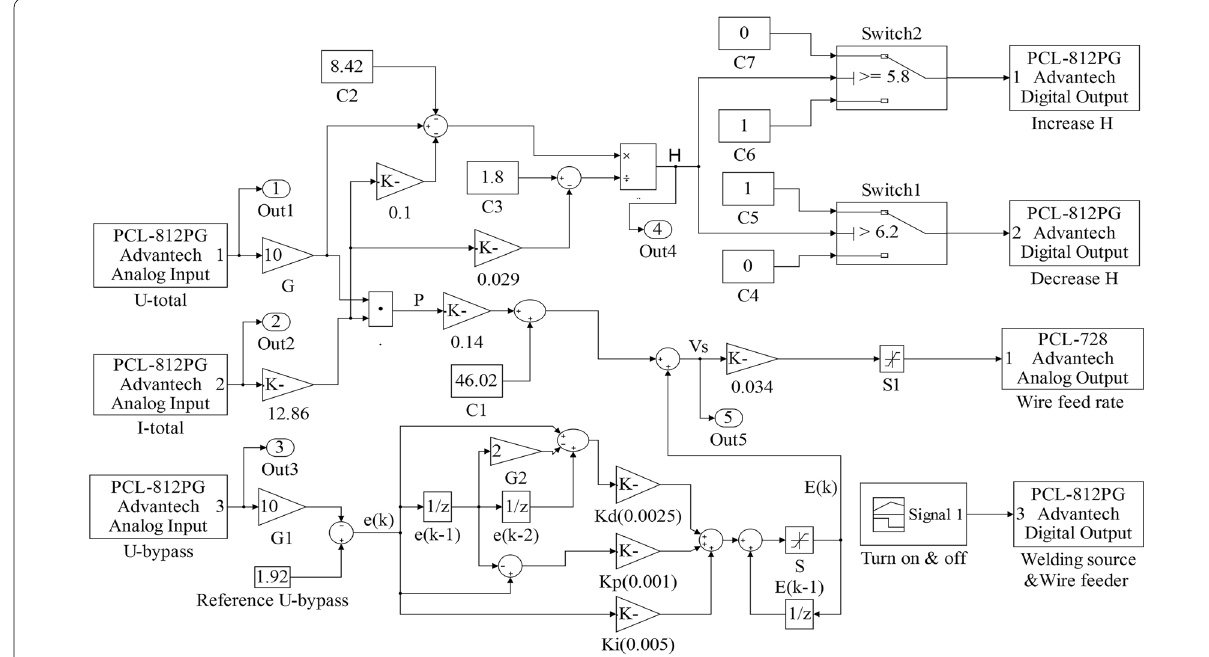
Figure 12 Diagram of self-adaptive DE-MPAW control